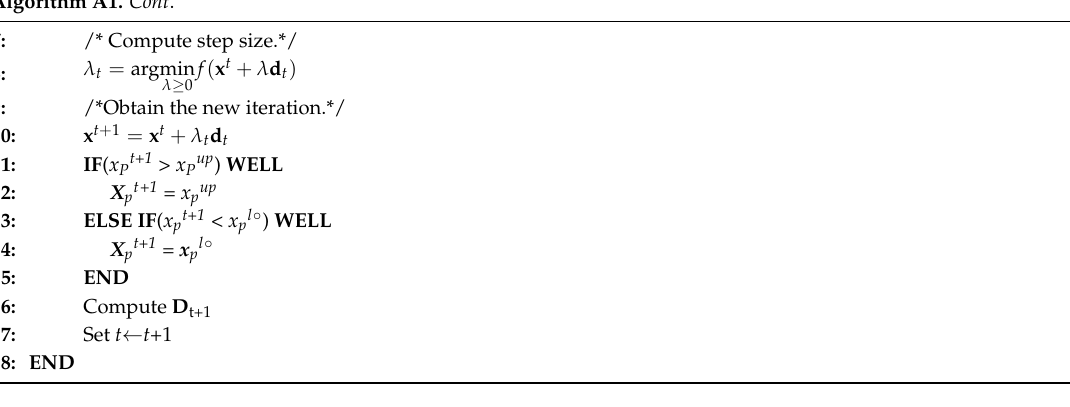
Algorithm A1. Cont .